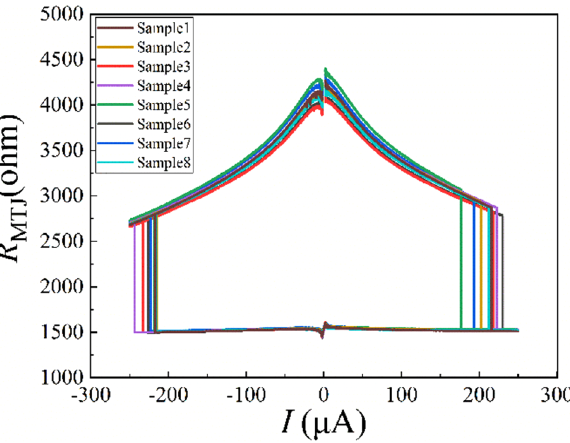
Figure 2. Current induced magnetization switching characteristics of MTJ devices before radiation. Sample 1 ~ sample8 are randomly selected eight devices.